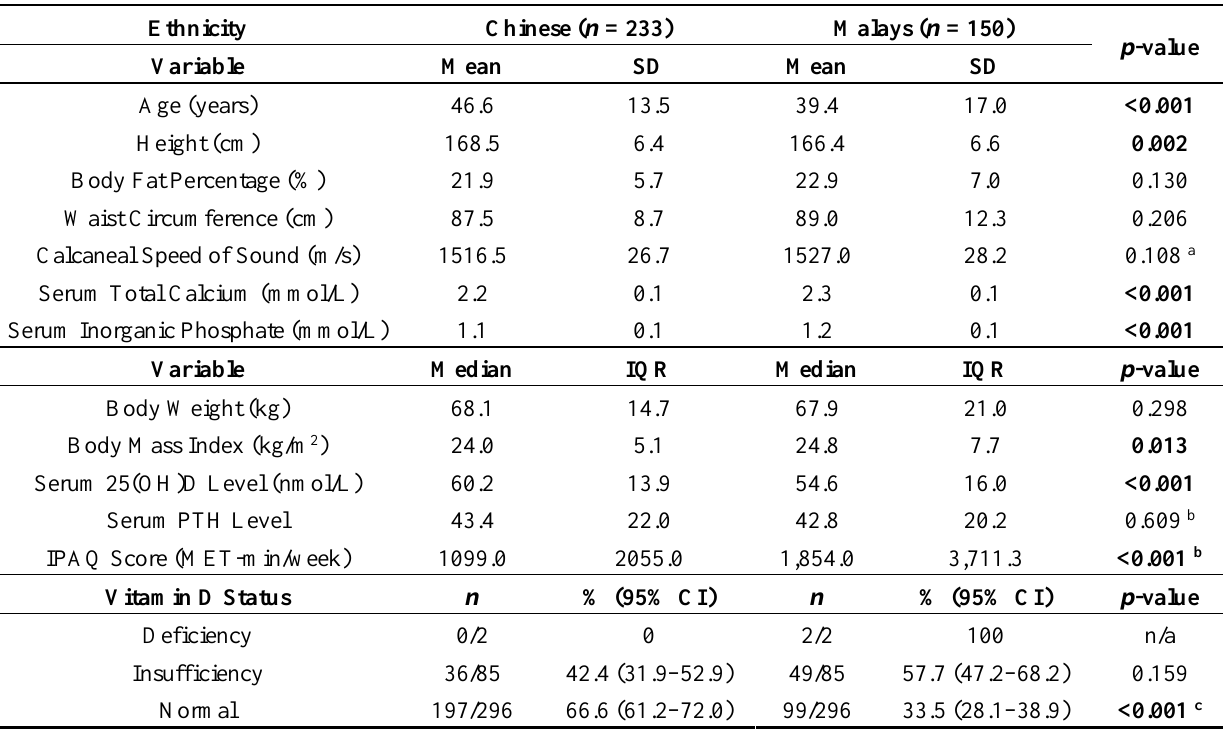
Table 1. The difference in characteristics between Chinese and Malay subjects. IPAQ, International Physical Activity Questionnaire; MET, metabolic rate; n/a, not applicable; PTH, parathyroid. Chinese ( n =